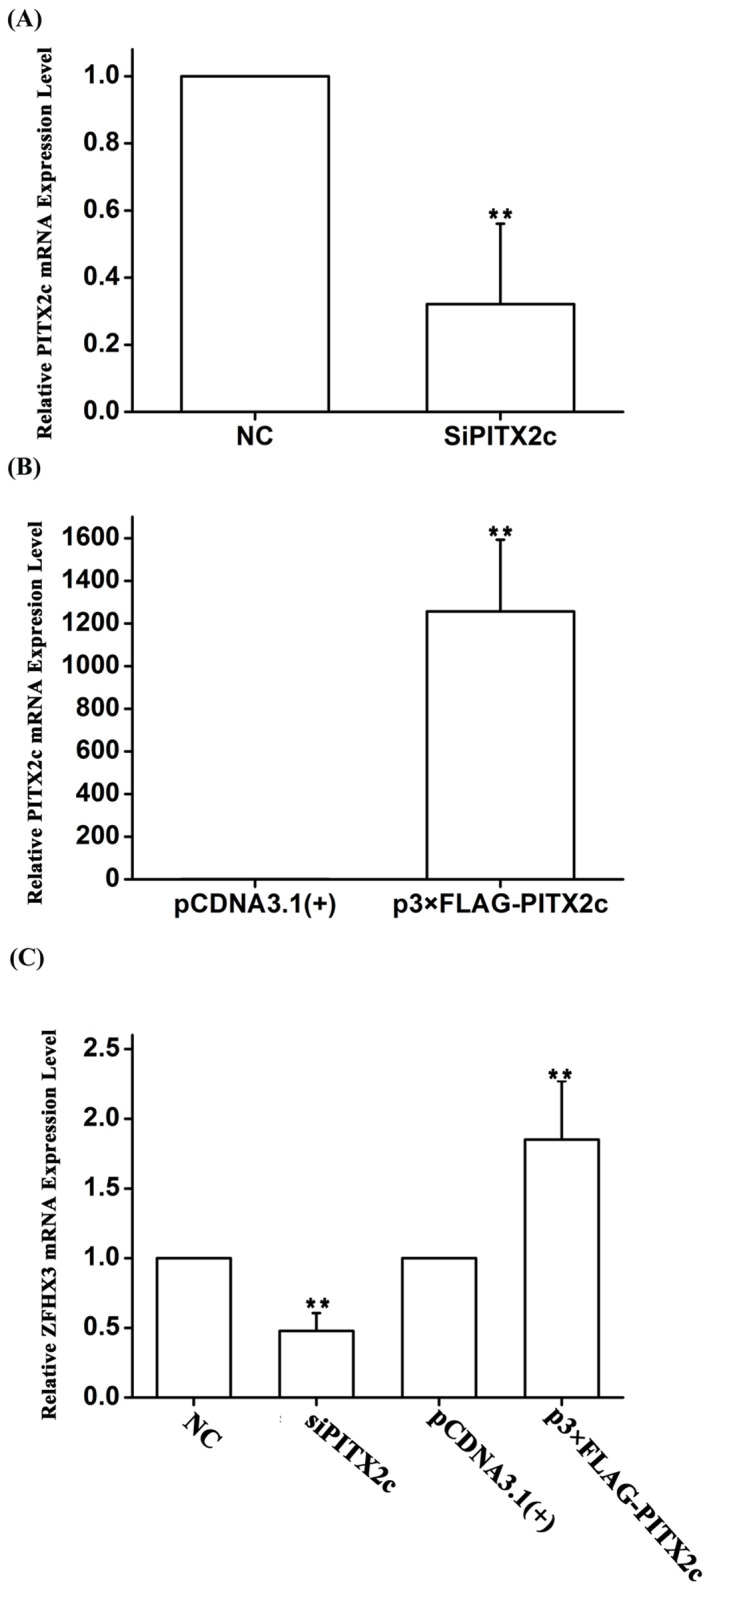
The PITX2c gene positively regulates expression of the ZFHX3 gene. HCT116 cells were transfected with siRNA specific for PITX2c or an expression plasmid for PITX2c and used for isolation of total RNA samples and real time RT-PCR analysis.A. Real-time RT-PCR analysis for PITX2c. Transfection of siRNA for PITX2c successfully reduced expression of PITX2c. B. Real-time RT-PCR analysis for PITX2c. Transfection of an expression plasmid for PITX2c successfully increased expression of PITX2c. C. Real-time RT-PCR analysis for ZFHX3. Transfection of siRNA for PITX2c reduced expression of ZFHX3. Transfection of an expression plasmid for PITX2c successfully increased expression of ZFHX3. **P<0.01.